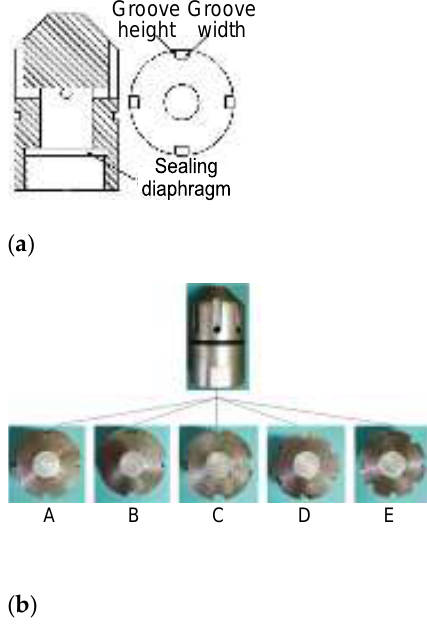
Figure 1. Visual simulated experiment system.